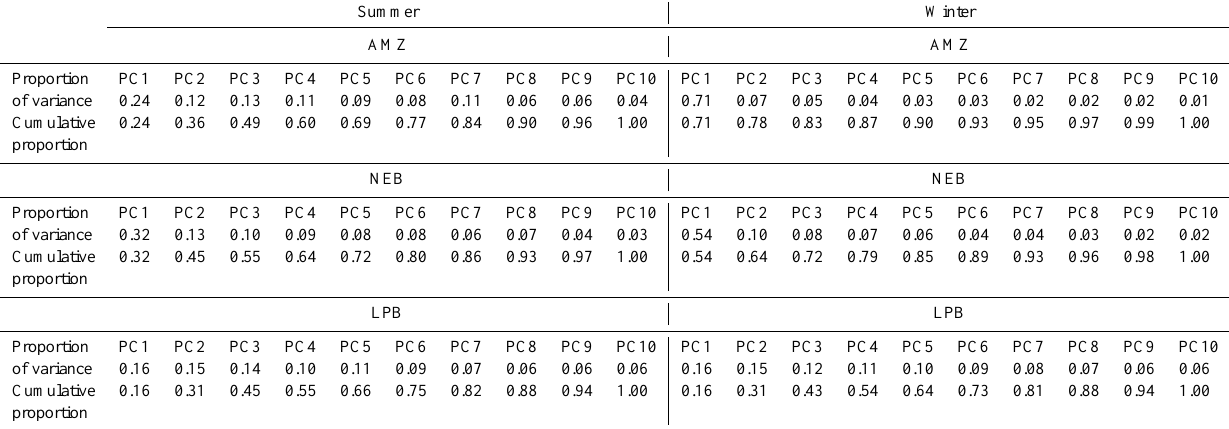
Table 2. Proportion and cumulative proportion of variance for the indicated regions. Left column for summer, and right column for winter.